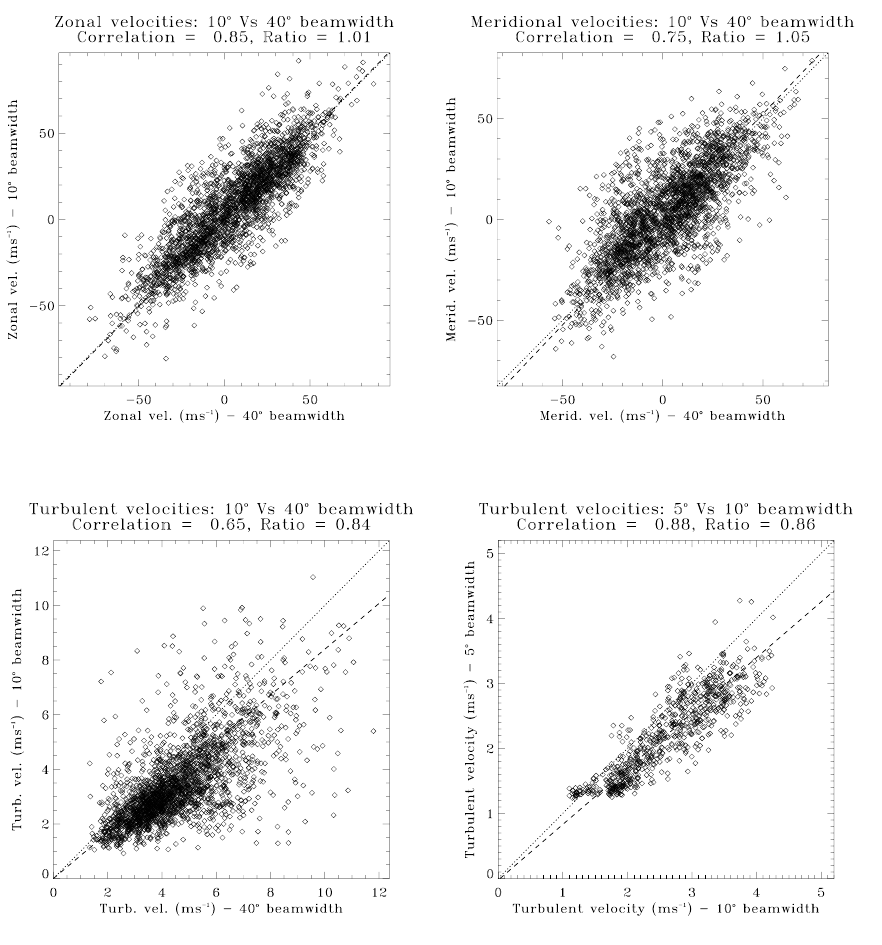
Fig. 1. Scatter plot of (left) zonal and (right) meridional velocities esti- mated using half hourly averaged es- timates from 2-minute interleaved 10 ◦ and 40 ◦ observations during November 1996. The dotted line on both plots in- dicates y = x . The dashed line indi- cates the results of a total least squares fit, whose slope is indicated at the top of the plot. Fig. 2. Scatter plot of turbulent veloc- ities estimated using (left) half hourly averaged estimates from 2-minute inter- leaved 10 ◦ and 40 ◦ observations during November 1996, and (right) using 5 ◦ and 10 ◦ observations. Each data point for the bottom plot is obtained by com- paring the turbulent velocity estimated using a 10 ◦ beamwidth with that ob- tained in the same fortnightly period in a different year when the 5 ◦ beamwidth was used. The dashed line indicates the results of a total least squares fit, whose slope is indicated at the top of the plot.